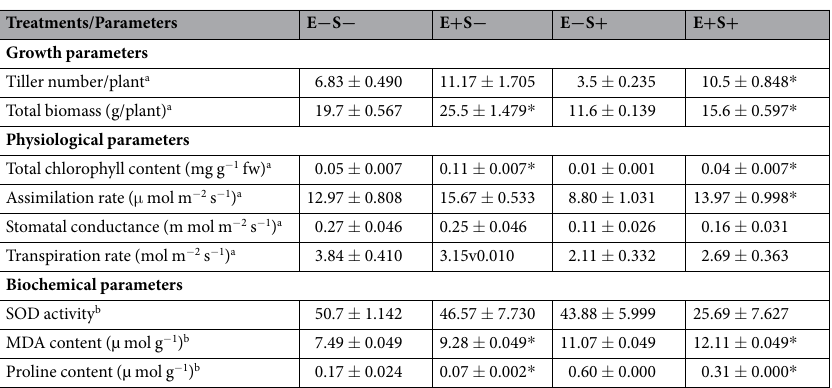
Table 1. Growth, physiological and biochemical responses of IR-64 plants subjected to different treatments (E + /E − : Presence/absence of Fusarium sp .; S + /S − : Presence/absence of Salinity stress) ( a 50 day old plants; b 10 day old seedlings). One-way ANOVA was done separately for E − S- and E + S − and for E − S + and E + S + . Results are the mean of three replication ± SEm. Asteriks indicate significant difference between means within each of the above pairs of comparison at P <